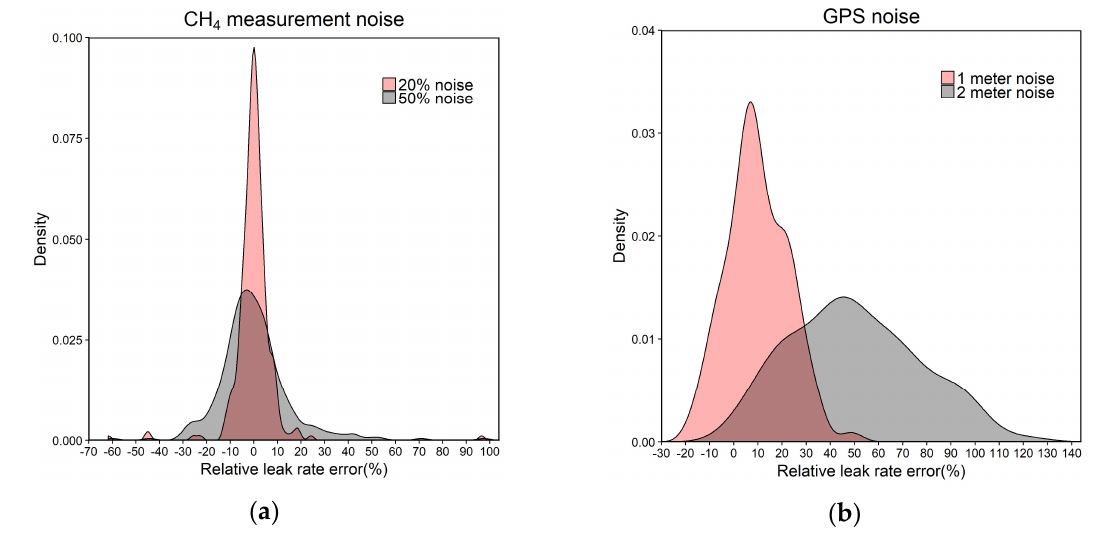
Figure 12. ( a ) Distribution of leak rate errors after adding 20% (red shape) and 50% noise (grey shape) to the CH 4 mixing ratio measurements. ( b ) Distribution of leak rate errors after adding 1-m (red shape) and 2-m noise (grey shape) to the GPS data.